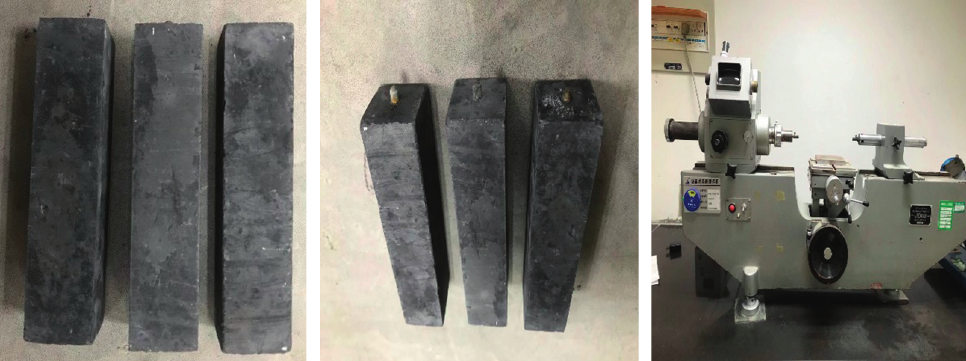
Figure 3: Samples and test setup of shrinkage test.